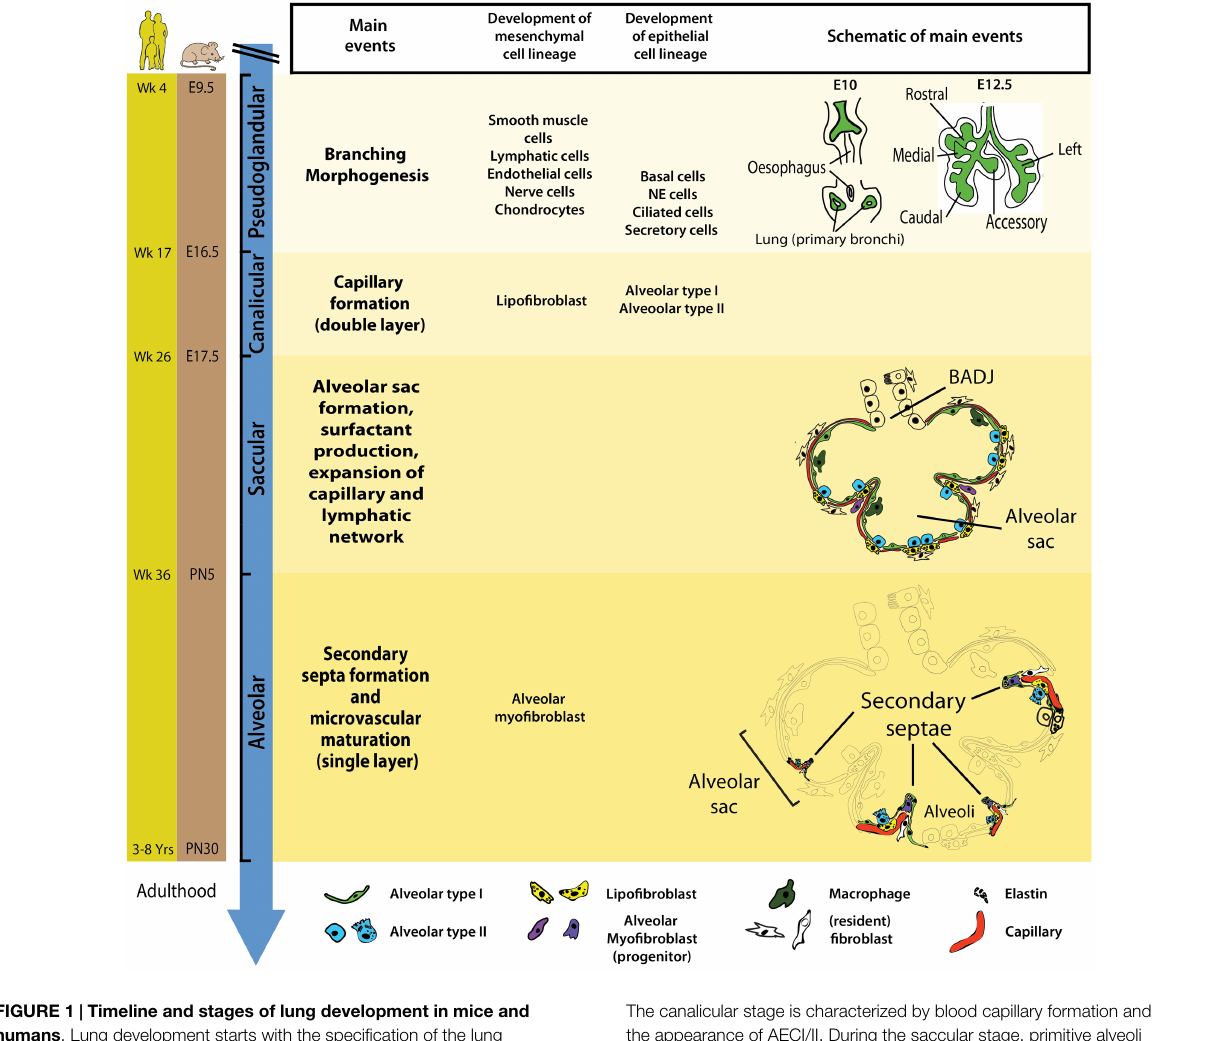
The canalicular stage is characterized by blood capillary formation and the appearance of AECI/II. During the saccular stage, primitive alveoli (sac-like structures) start to form and this is accompanied by surfactant production and the expansion of capillary and lymphatic networks. The alveolar stage of lung developments starts in utero in humans whereas in mice, it starts postnatally. Wk, week; E, embryonic; PN, postnatal; NE,